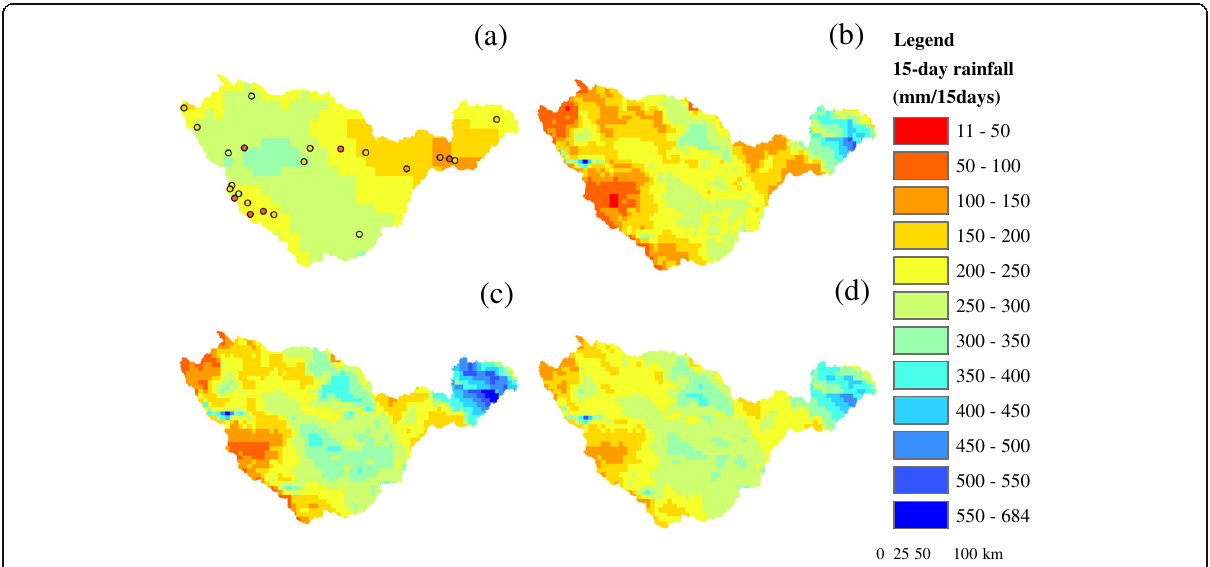
Fig. 3 Comparison of average annual maximum 15-day rainfall maps. a GSMaP with gauged rainfall data (2001 – 2013), b original data, c QM bias- corrected data, and d QM and VS-corrected NHRCM data. Note that the 15-day gauged rainfall data are estimated at the same time as the annual maximum of the GSMaP